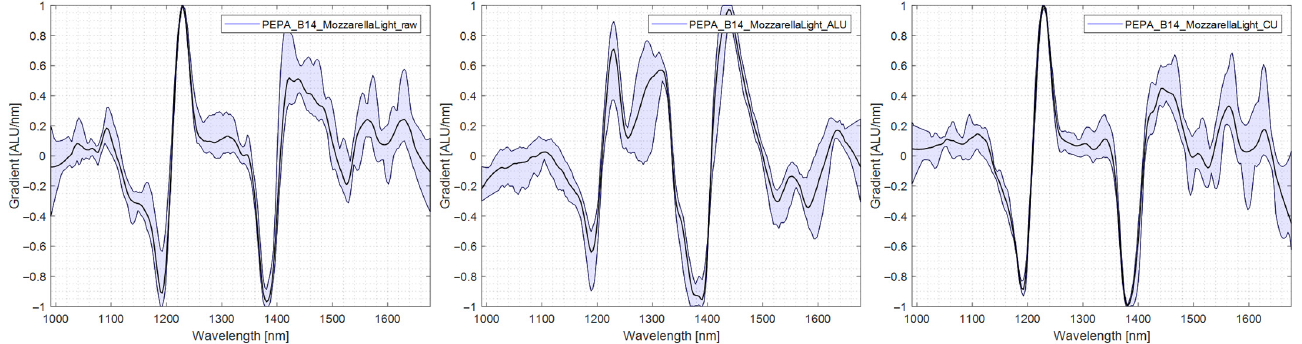
Figure 15. Comparison of PE/PA spectra, left : no reflector, middle: aluminium reflector, right : copper reflector.